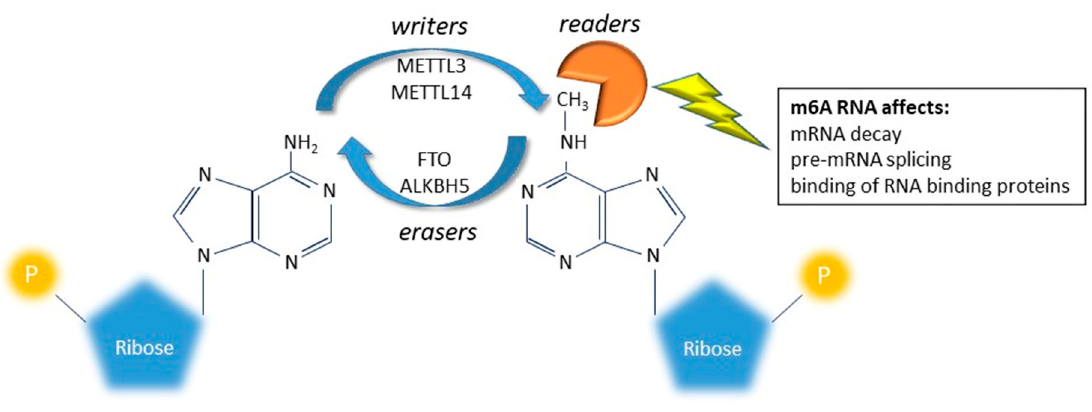
Figure 3. Graphical representation of m6A RNA modification. Adenosine is methylated in position N6 to form m6A by a class of enzymes globally called “writers” and demethylated by a class of enzymes called “erasers.” The two classes of enzymes work together to balance the level of m6A. The m6A message is interpreted by another class of enzymes called “readers” and plays an important role in regulating gene expression by fine modulating different aspects (processing, stability, translation etc.) of RNA molecules.